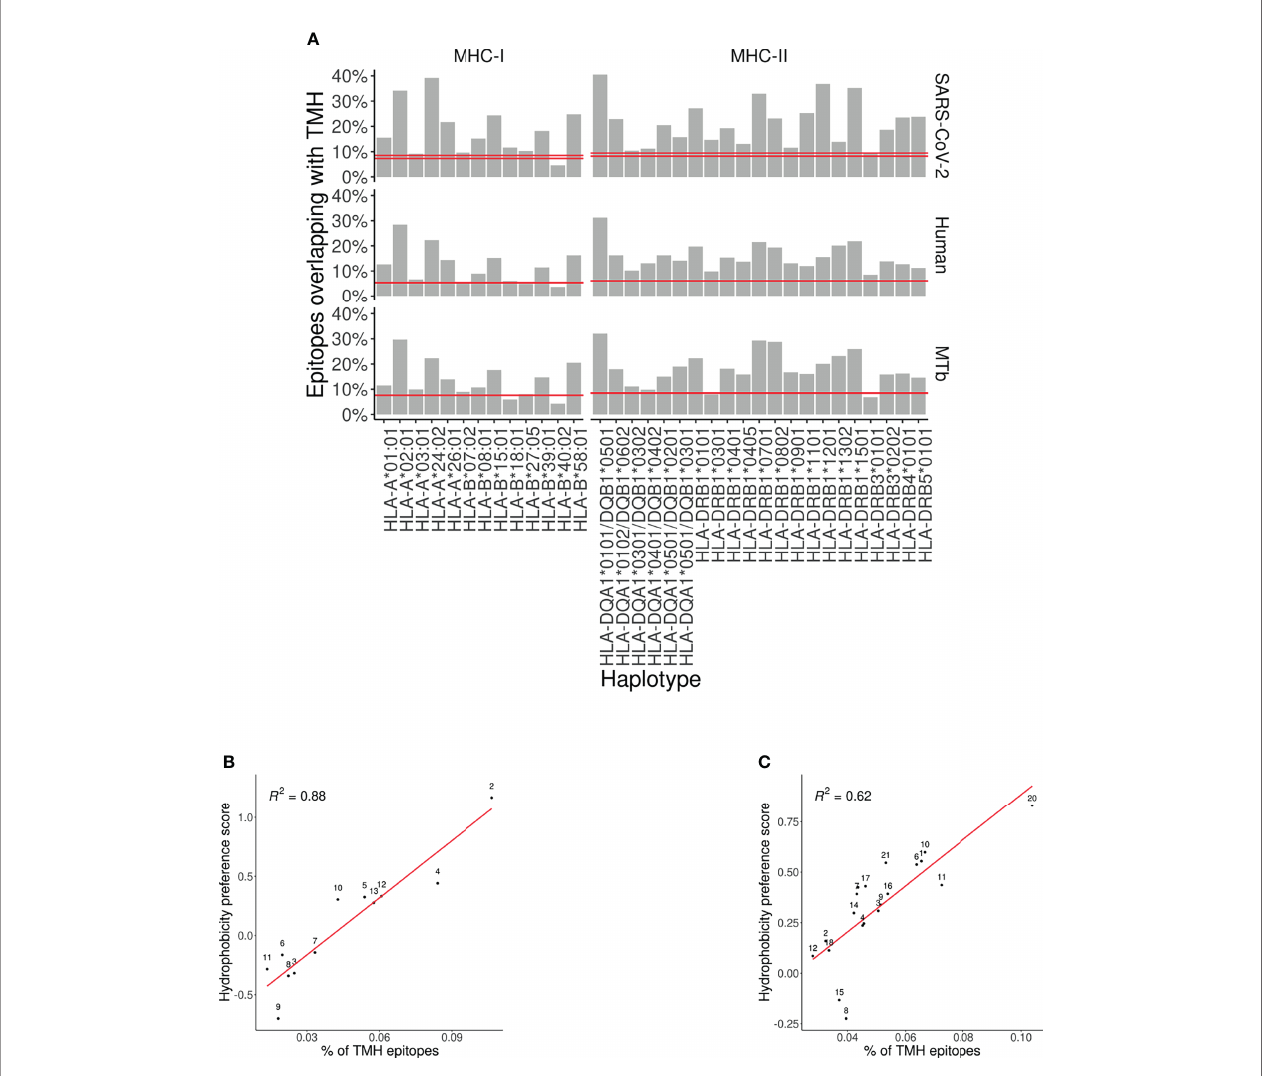
FIGURE 1 | Over-presentation of TMH-derived epitopes on most MHC-I and -II alleles (A) The percentage of epitopes for MHC-I and -II alleles that are predicted to overlap with TMHs for the proteomes of SARS-CoV-2 (top row), human (middle row) and M. tuberculosis (MtB; bottom row). The pair of horizontal red lines in each plot indicate the lower and upper bound of the 99% con fi dence interval. See Supplementary Tables S5 and S7 for the exact TMH and epitope counts. (B, C) Correlation between the percentages of predicted TMH-derived epitopes and the hydrophobicity score of all predicted epitopes for human MHC-I (B) and MHC-II alleles (C) . Diagonal red line: linear regression analysis. Labels are shorthand for the HLA alleles, see the Supplementary Table S8 for the